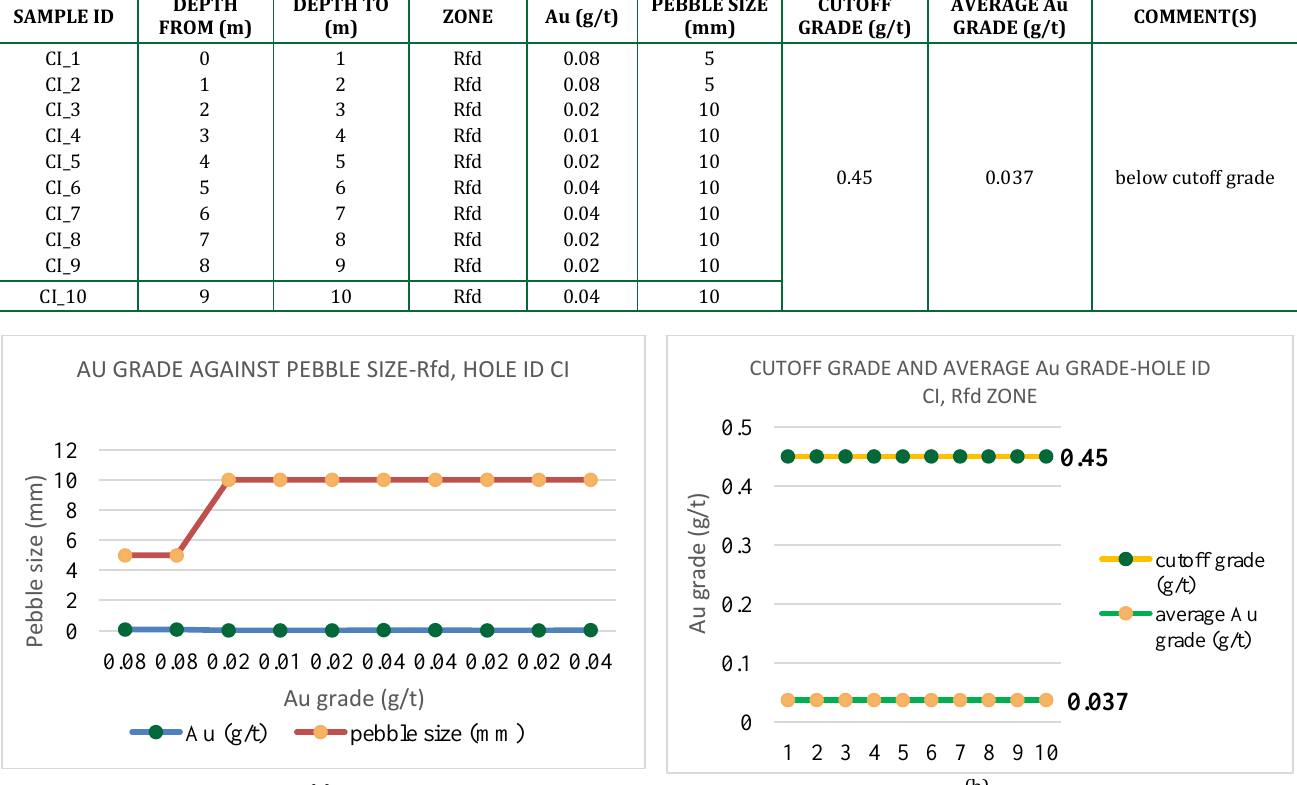
Table 7: Analysis for Hole Id Ci-Rfd Zone